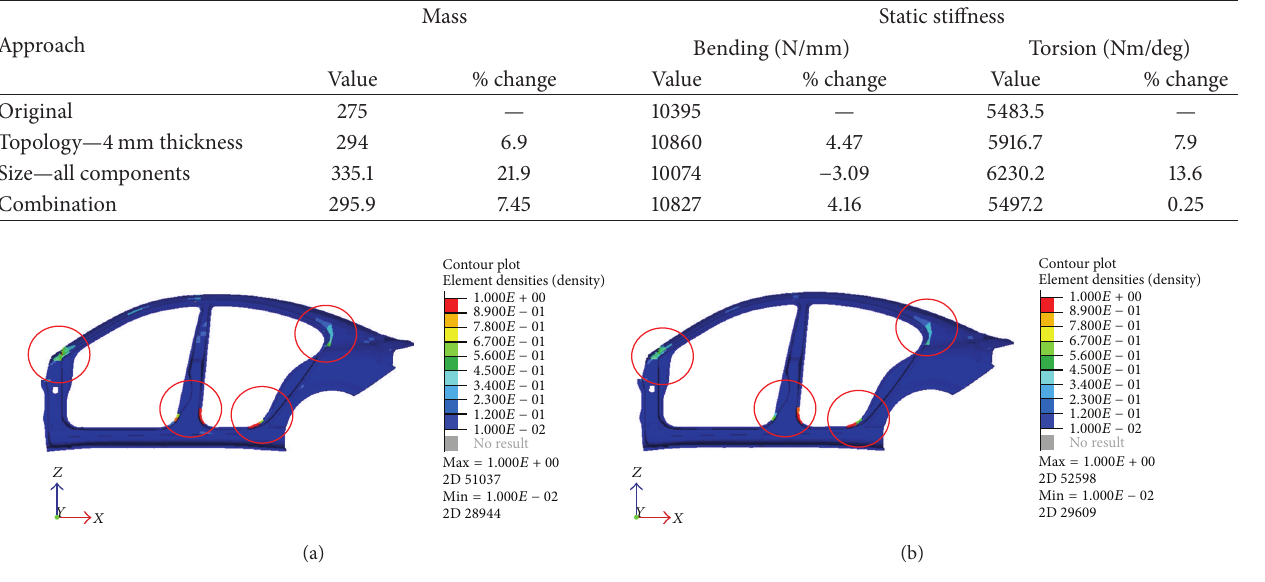
Table 7: Mass and static stiffness results from each optimization approach.